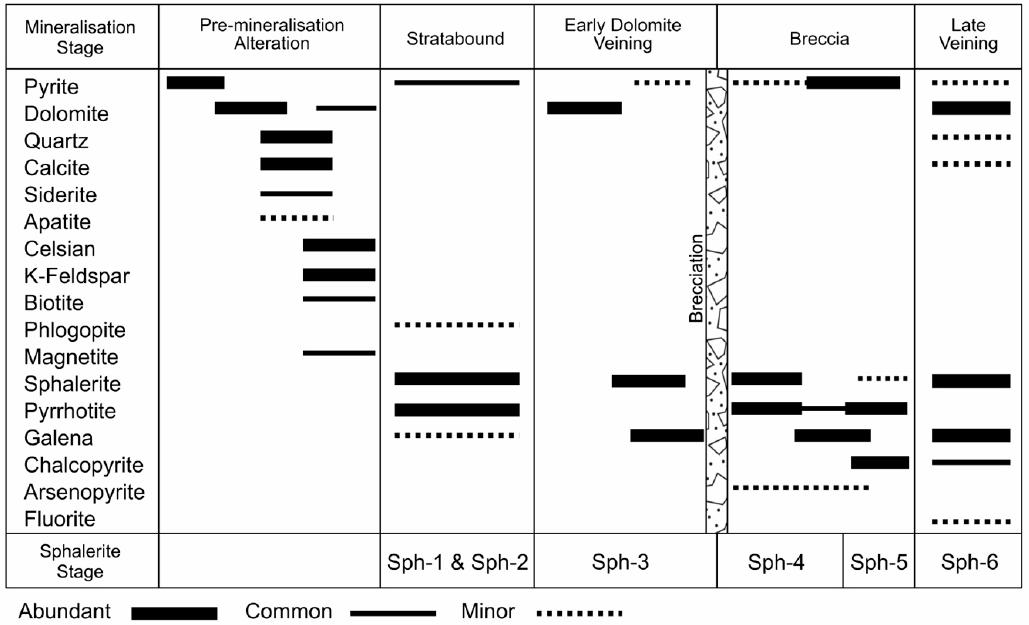
Figure 2. Paragenesis of the Hilton Zn-Pb (Ag) deposit based on the samples from this study. Pre-mineralisation alteration is followed by stratabound mineralisation containing sph-1 and sph-2. Early dolomite veins contain sph-3 and are followed by a stage of brecciation and the emplacement of sph-4. This is overprinted by Pb and Cu mineralisation where sph-4 is recrystallised to produce sph-5. Multiple varieties of late veins crosscut all types of mineralisation and contain sph-6.